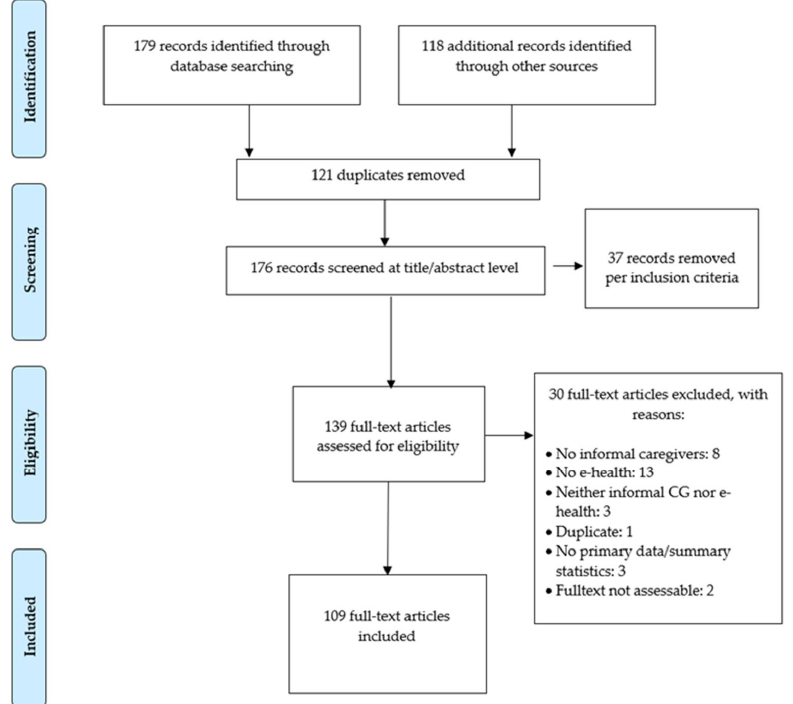
Figure 1. Flow chart.